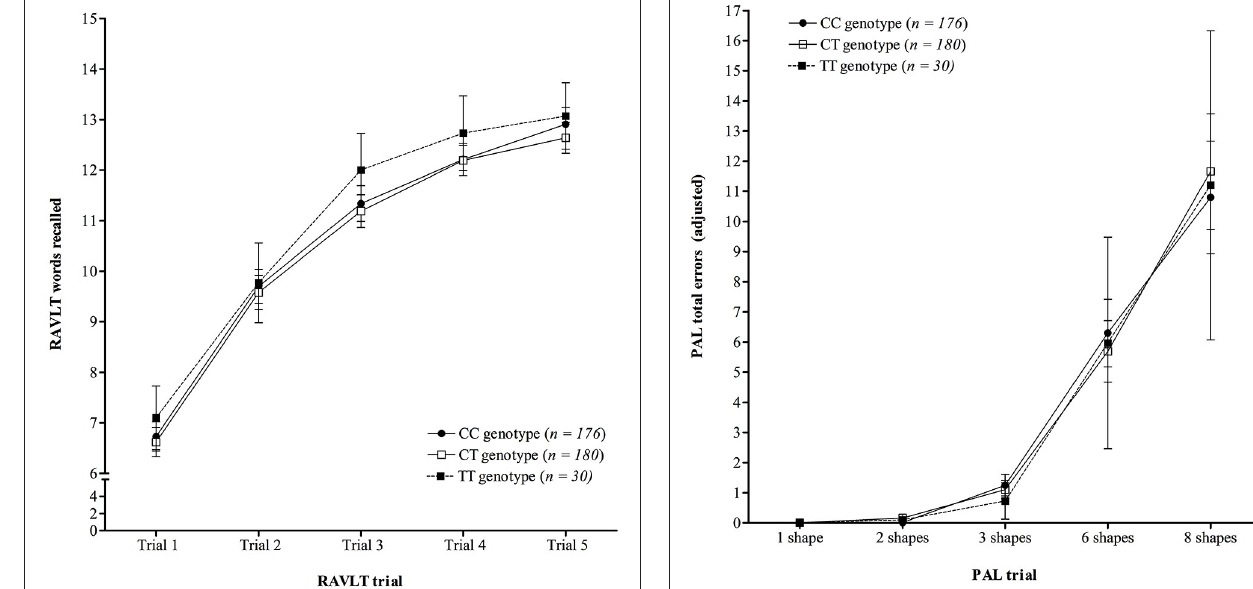
FIGURE 1 | Mean number of words recalled on each trial of the RAVLT across KIBRA genotype, showing no significant interaction . Error bars display 95% confidence intervals.